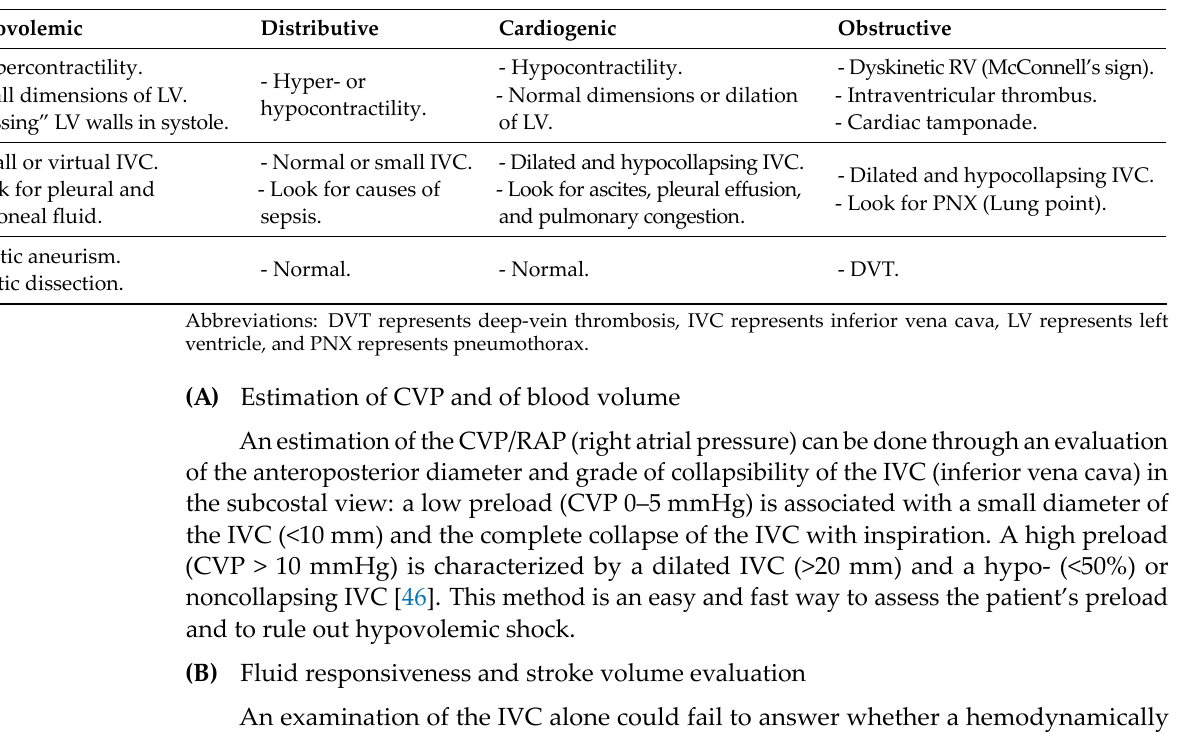
Distributive Septic, neurogenic, anaphylactic.